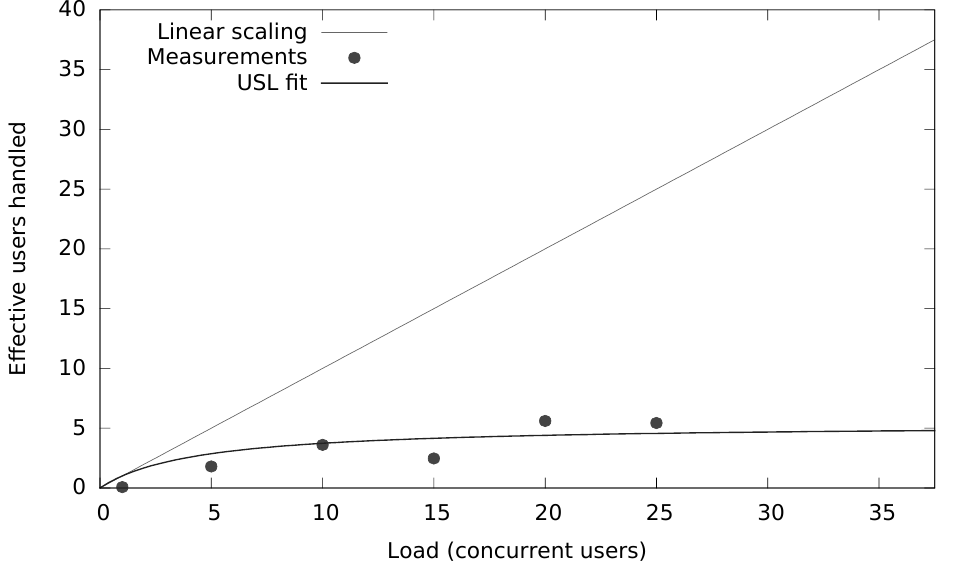
Figure 10. Fraud velocity rule without secondary index.